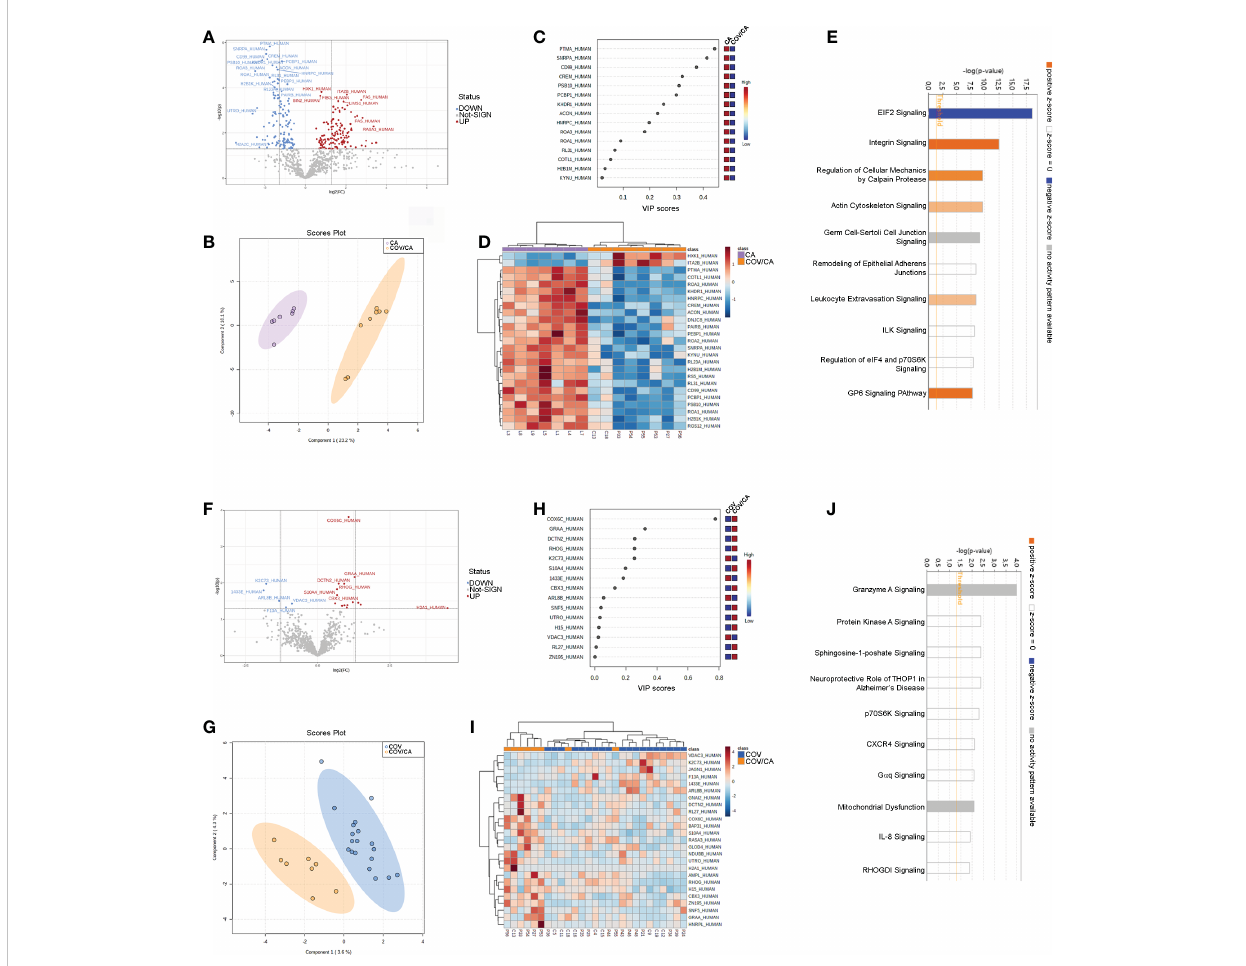
FIGURE 5 Proteomic characterization of PBMCs in CA vs COV/CA patients. (A) volcano plot reporting the modulation of 264 proteins (FC > 1.3 and p -value < 0.05), 135 over-expressed and 129 under-expressed proteins; (B, C) Sparse partial least square discriminant analysis (sPLS-DA) of PBMC proteomic pro fi les, showing (B) the presence of two separate groups of patients and (C) the most important discriminating variables for each group. Colored boxes indicate the most predictive or discriminative features in each group (red, high; blue, low). (D) The hierarchical heat maps of the abundances of quanti fi ed proteins, highlighting the two clusters of samples, with cancer COVID-19 (COV/CA) patients in orange and cancer (CA) patients in purple. (E) Bar-plot presenting the top canonical pathway analysis of signi fi cantly altered PBMCs proteins regulated in COV/CA vs CA. (F – J) Volcano plot, sparse partial least square analysis, heatmap of protein abundances, and canonical pathway analysis in COV/CA vs COV patients, 15 proteins were over-expressed while 5 were under-expressed. CA ( n = 7), COV ( n = 19) and COV/CA ( n = 8)